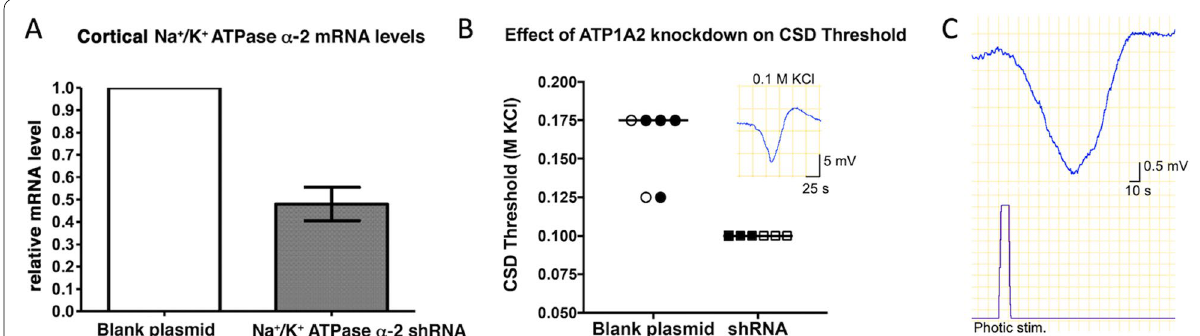
fig. 4 Knocking down cortical α2‑Na + /K + ‑ATPase lowered the CSD threshold. Intracortical injection of α2‑Na + /K + ‑ATPase shRNA‑coding plasmids to the occipital cortex led to a 50% decrease in α2‑Na + /K + ‑ATPase mRNA level as detected by qRT‑PCR (left, p the CSD induction threshold (right) as assessed with varying concentrations of KCl (from 0.050 to 0,175 M) 6 (clear symbols) or 24 h (filled symbols) after injection compared to the blank plasmid‑injected group (median KCl‑triggered CSD recorded from an ATP1A2 knockdown cortex is shown over the shRNA data points. A photic stimulation‑triggered CSD (without KCl or ouabain treatment) from an ATP1A2 knockdown mouse is displayed on the